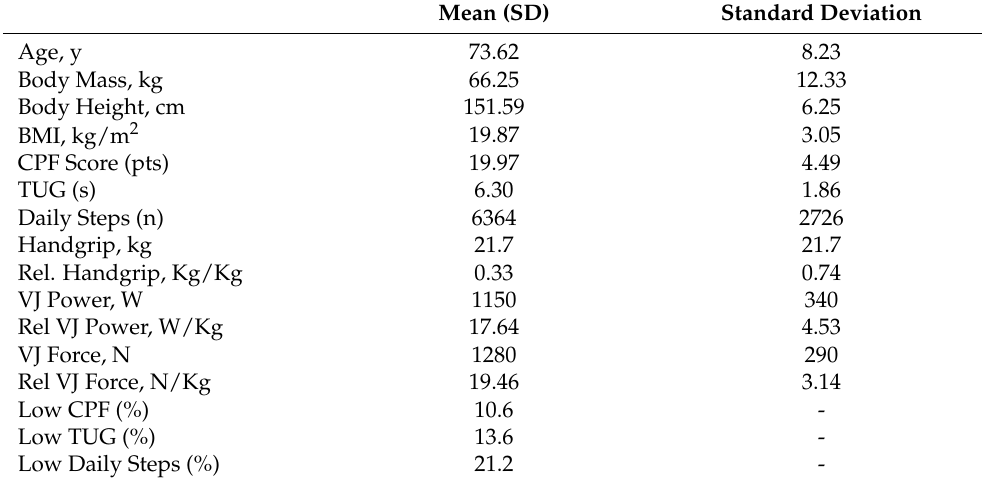
Table 1. Characterization of the